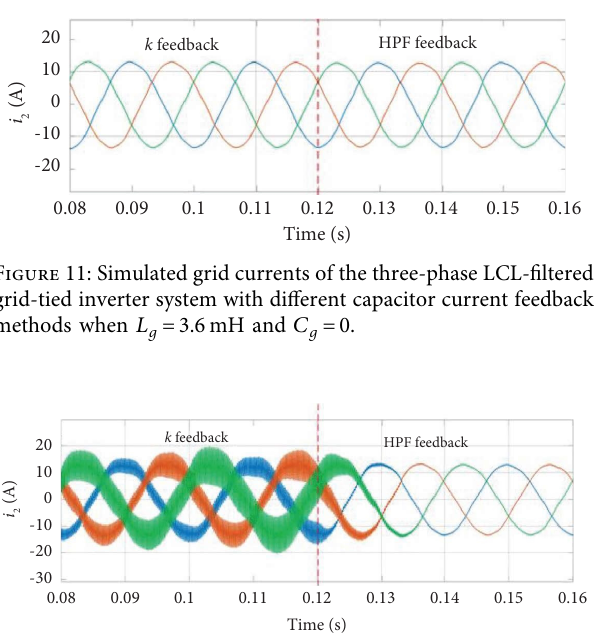
Figure 12: Simulated grid currents with diferent capacitor current feedback methods when L g � 3.6mH and C g � 2 μ F.